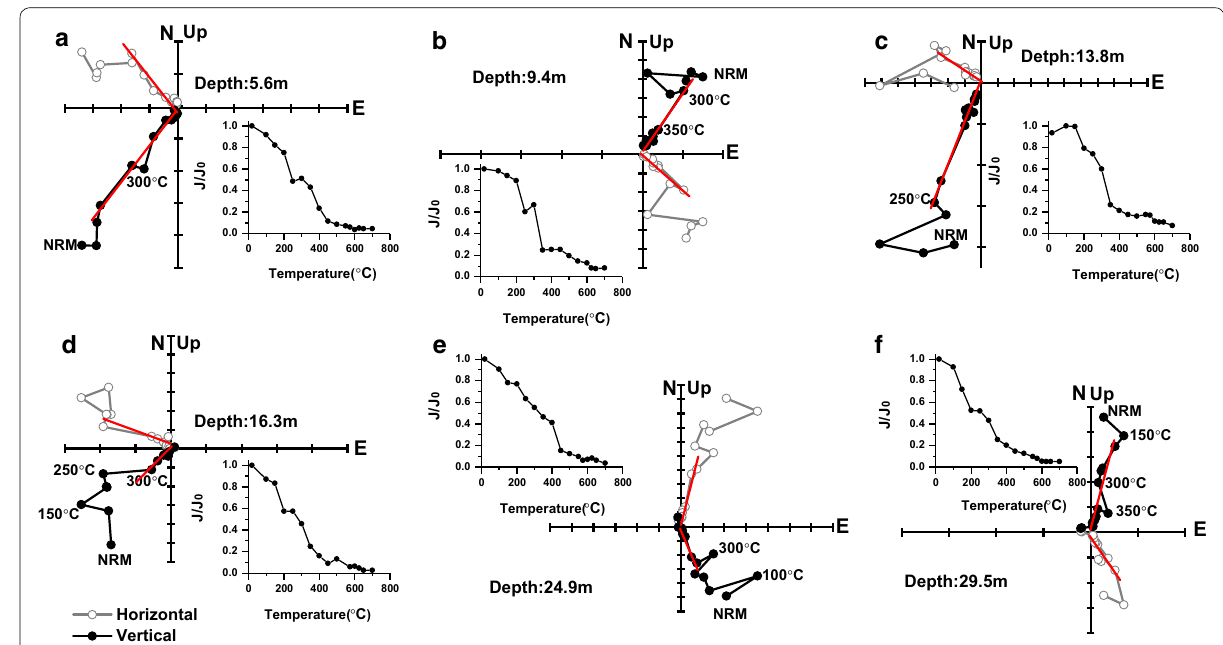
Fig. 5 Orthogonal vector projections obtained from THD of typical samples (modified from Li 2016). a Typical sample at the depth of 5.6 m, b typi- cal sample at the depth of 9.4 m, c typical sample at the depth of 13.8 m, d typical sample at the depth of 16.3 m, e typical sample at the depth of 24.9 m, and f typical sample at the depth of 29.5 m in the BYH section. Red lines indicate the stable component isolated by thermal demagnetiza-